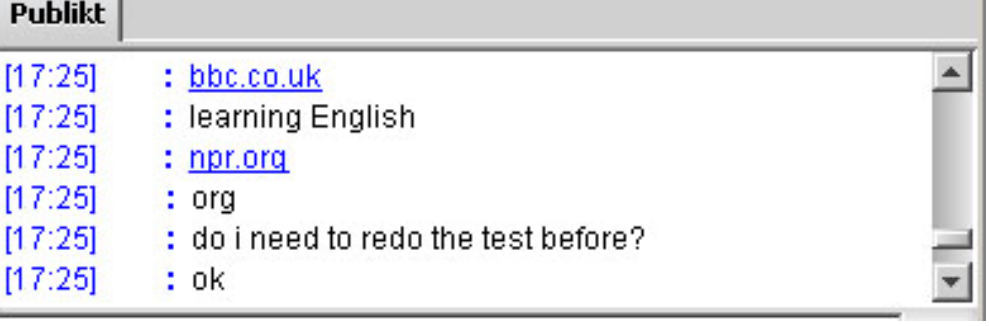
Figure 7 . URLs (names removed from